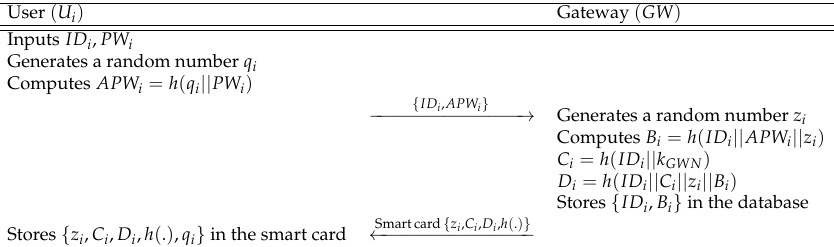
Figure 3. User registration phase of Moghadam et al.’s